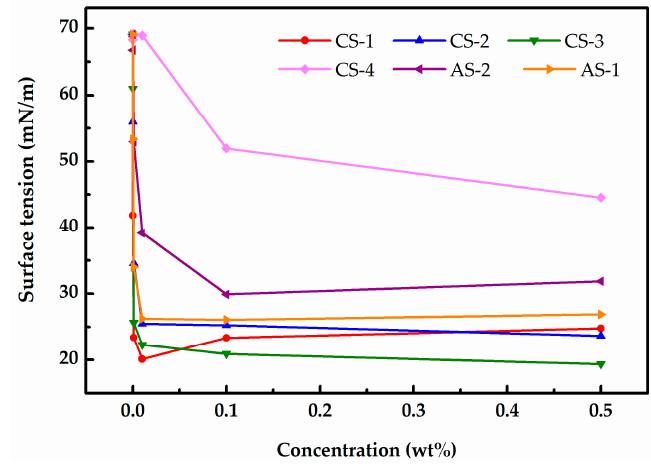
Figure 3. Relationship between surface tension vs surfactant concentration.